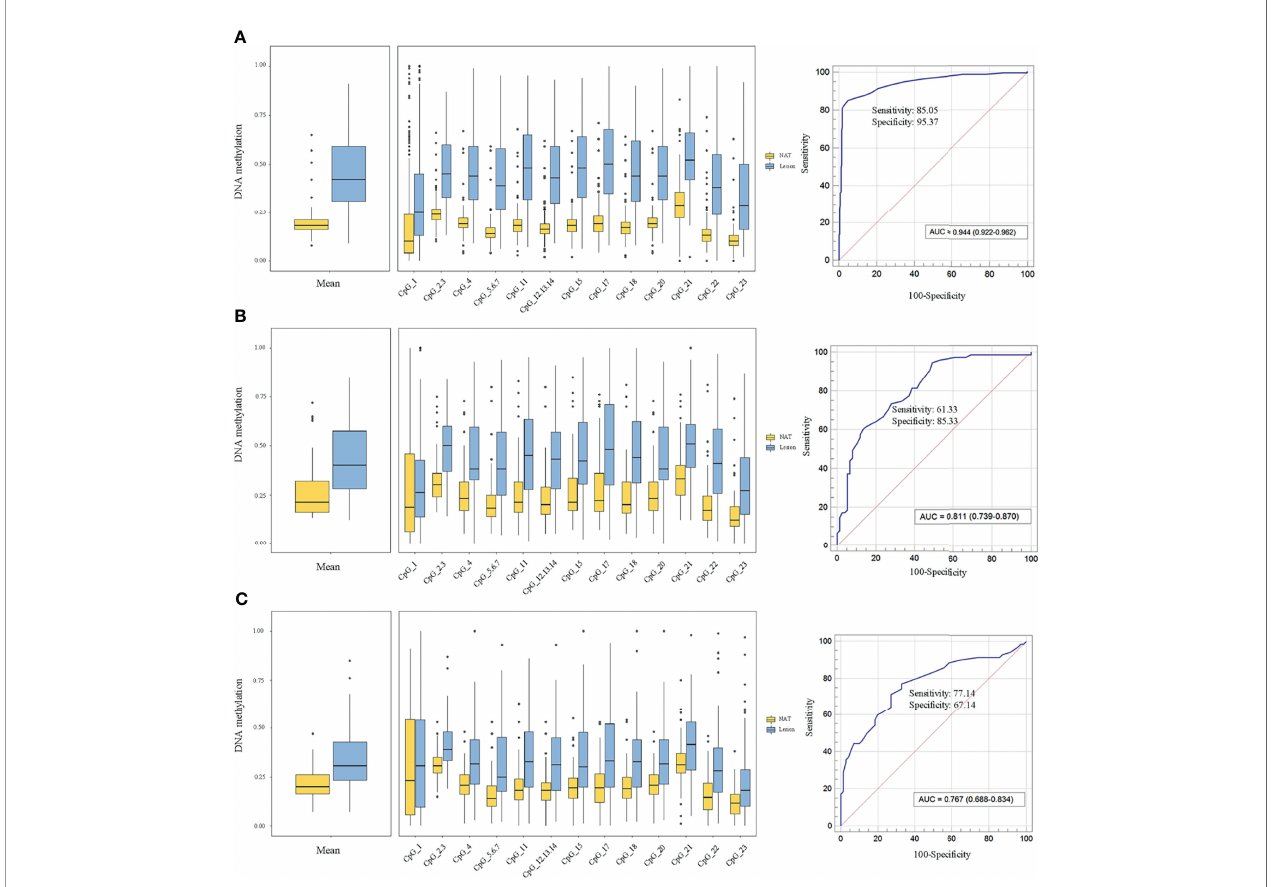
FIGURE 5 | Methylation levels of DLX6-AS1 quanti fi ed by MassARRAY EpiTYPER in cohort III and its discriminative ability. (A) Colorectal cancer (n = 281). (B) Advanced adenoma (n = 75). (C) Nonadvanced adenoma (n = 70). NAT, histologically normal tissue adjacent to the lesion.